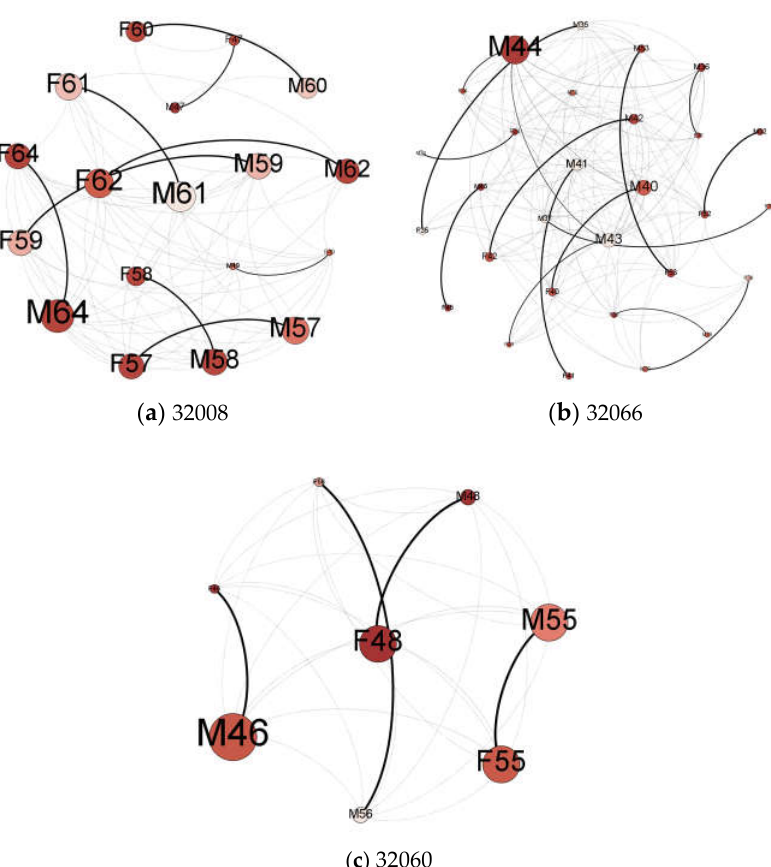
Figure 3. The inferred social network among Latino participants in each of the three communities (ZIP codes). The link width was scaled by the likelihood of social connection. The label “F” stands for “Father” and “M” for “Mother”. The size of nodes indicates their weighted degree centrality, and the tone of color shows their mental well-being scores (the darker the color, the better the mental well-being is). Open-source network analysis software, Gephi, was used to create graphs in Figures 3 and 4.